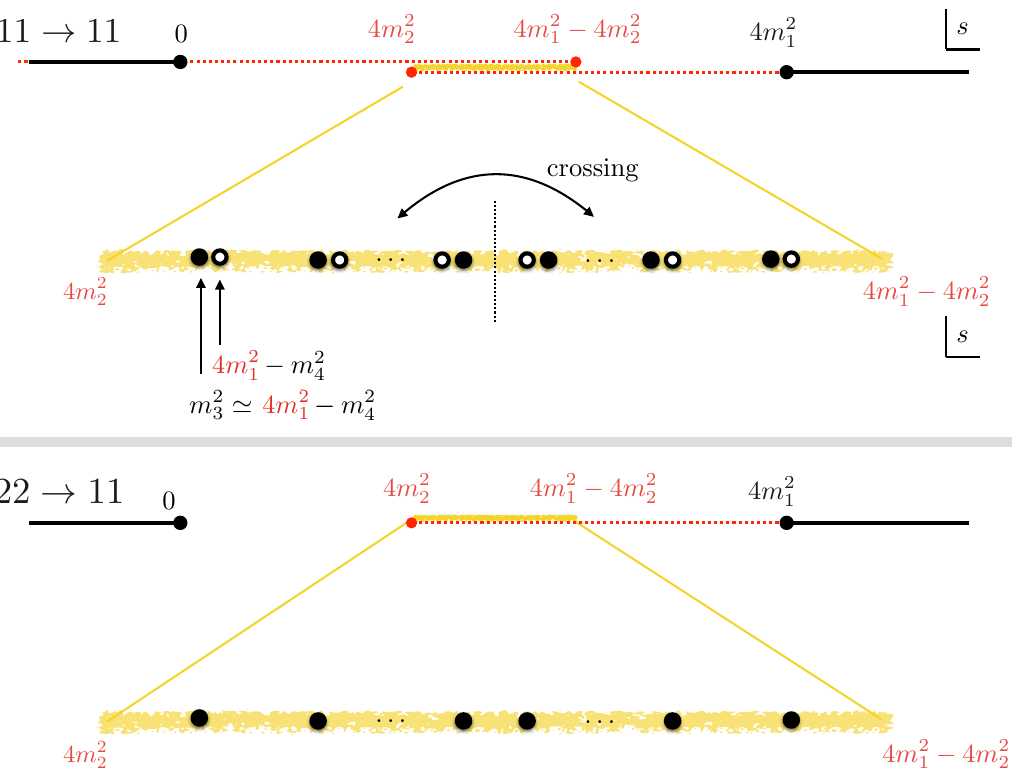
Figure 20. We can realize the screening mechanism with a large number of resonances with masses m 2 [4 m 2 ; 4 m 2 4 m 2 ] in crossing related pairs so that their contribution is moderate 2 1 (cid:0) 2 A 2 in the diagonal channels due to s - and t -channel pair-wise cancelations while, at the same time, having the potential to screen the non-diagonal processes where no t -channel poles show up (since the resonances are taken to be Z 2 even) and where the s -channel poles can have arbitrary sign as this is not a re(cid:13)ection symmetric